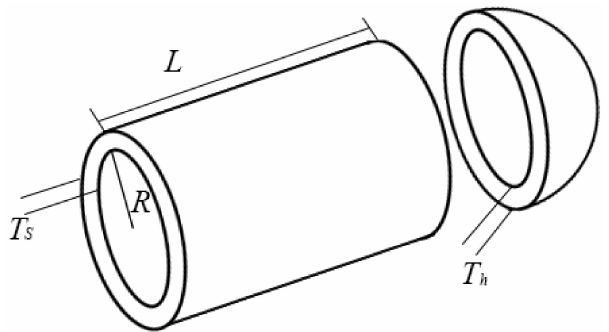
Figure 8. Pressure vessel